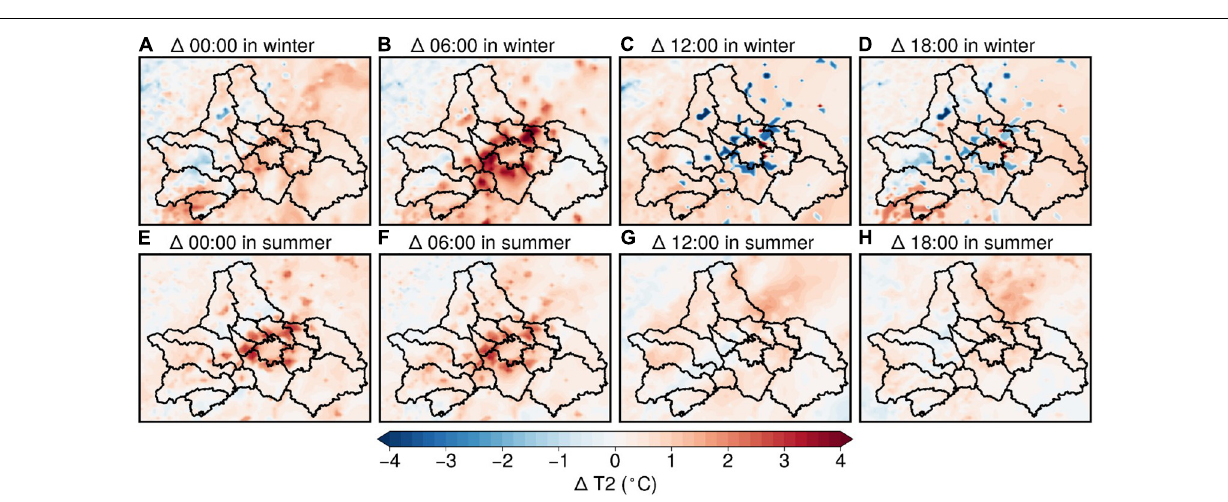
FIGURE 5 | Spatial map of T2 variations induced by land use change between 2000 and 2017 at 00:00, 06:00, 12:00, and 18:00 LST in winter (A–D) and summer (E–H)